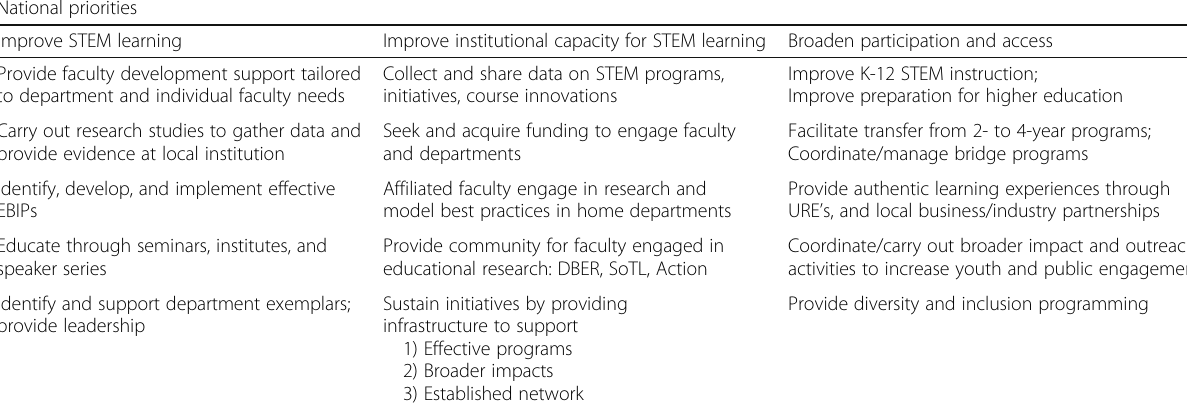
Table 6 SEC functions contributing to national priority areas in undergraduate STEM National priorities